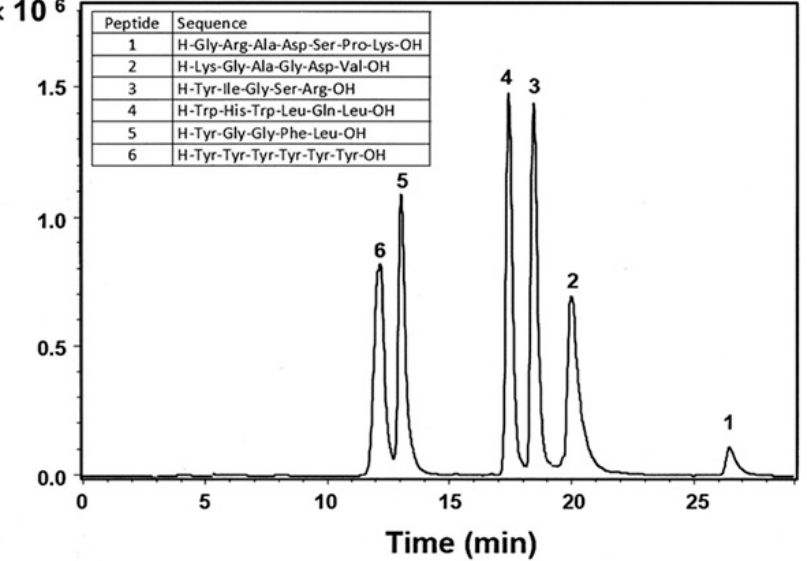
Figure 7. Separation of a mixture containing both hydrophobic and hydrophilic peptides in a single run on the Diamond Hydride column under aqueous normal phase conditions. Adapted from data in Reference [41].